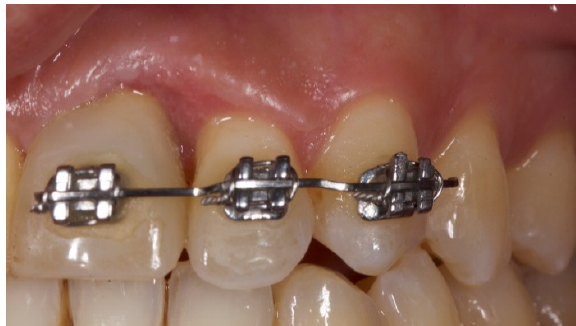
Figure 11. Orthodontic therapy.